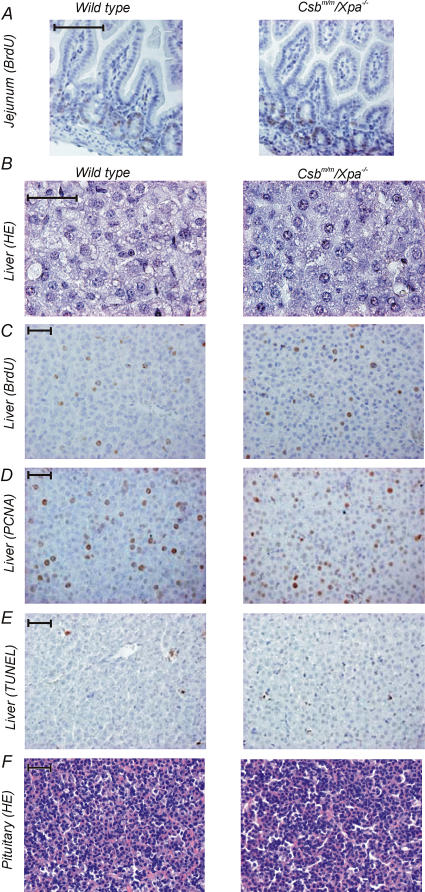
Histological Examination of Csbm/m/Xpa−/− Tissues(A) BrdU staining of the jejunum of Csbm/m/Xpa−/− and littermate control mice, showing normal proliferative capacity of the intestine in the double mutant mouse. (B–E) Histological examination of liver sections of 15-d-old Csbm/m/Xpa−/− and littermate control mice, stained with HE (B), immunostained for the proliferation markers (incorporated) BrdU (C) and PCNA protein (D), or TUNEL-stained for the presence of apoptotic cells (E). Quantification of the number of proliferative or apoptotic cells did not reveal significant differences between Csbm/m/Xpa−/− and wt littermate mice. (F) HE staining of the pituitary of Csbm/m/Xpa−/− and littermate control mice.